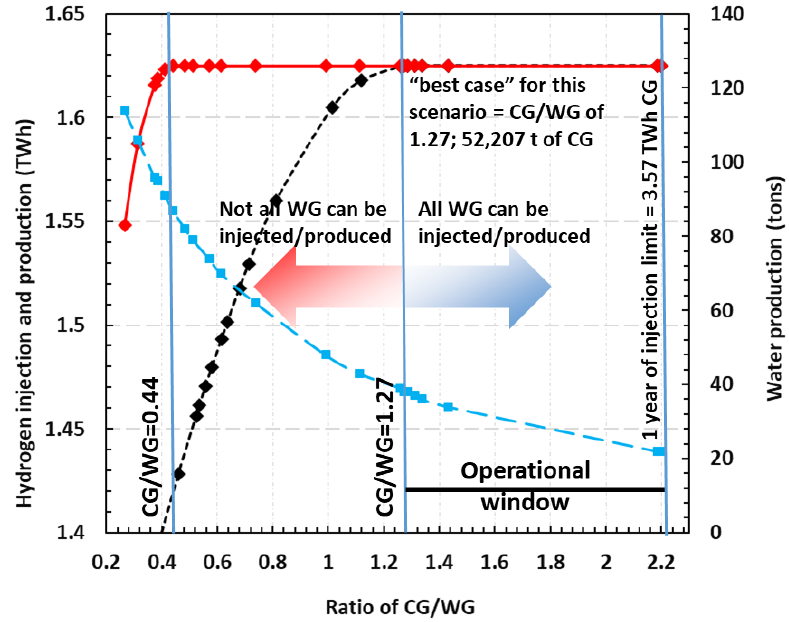
Figure 1. Base case results taken from [11]. The dashed black line represents the hydrogen (in TWh) that can be injected, depending on the CG in place. The red line represents the hydrogen (in TWh) that can be produced, again, depending on the CG. The scenario target total injection and production is 1.625 TWh, which can be injected and produced with a CG/WG ratio of at least 1.27. Diamonds represent individual simulation runs. See [11] for more information.